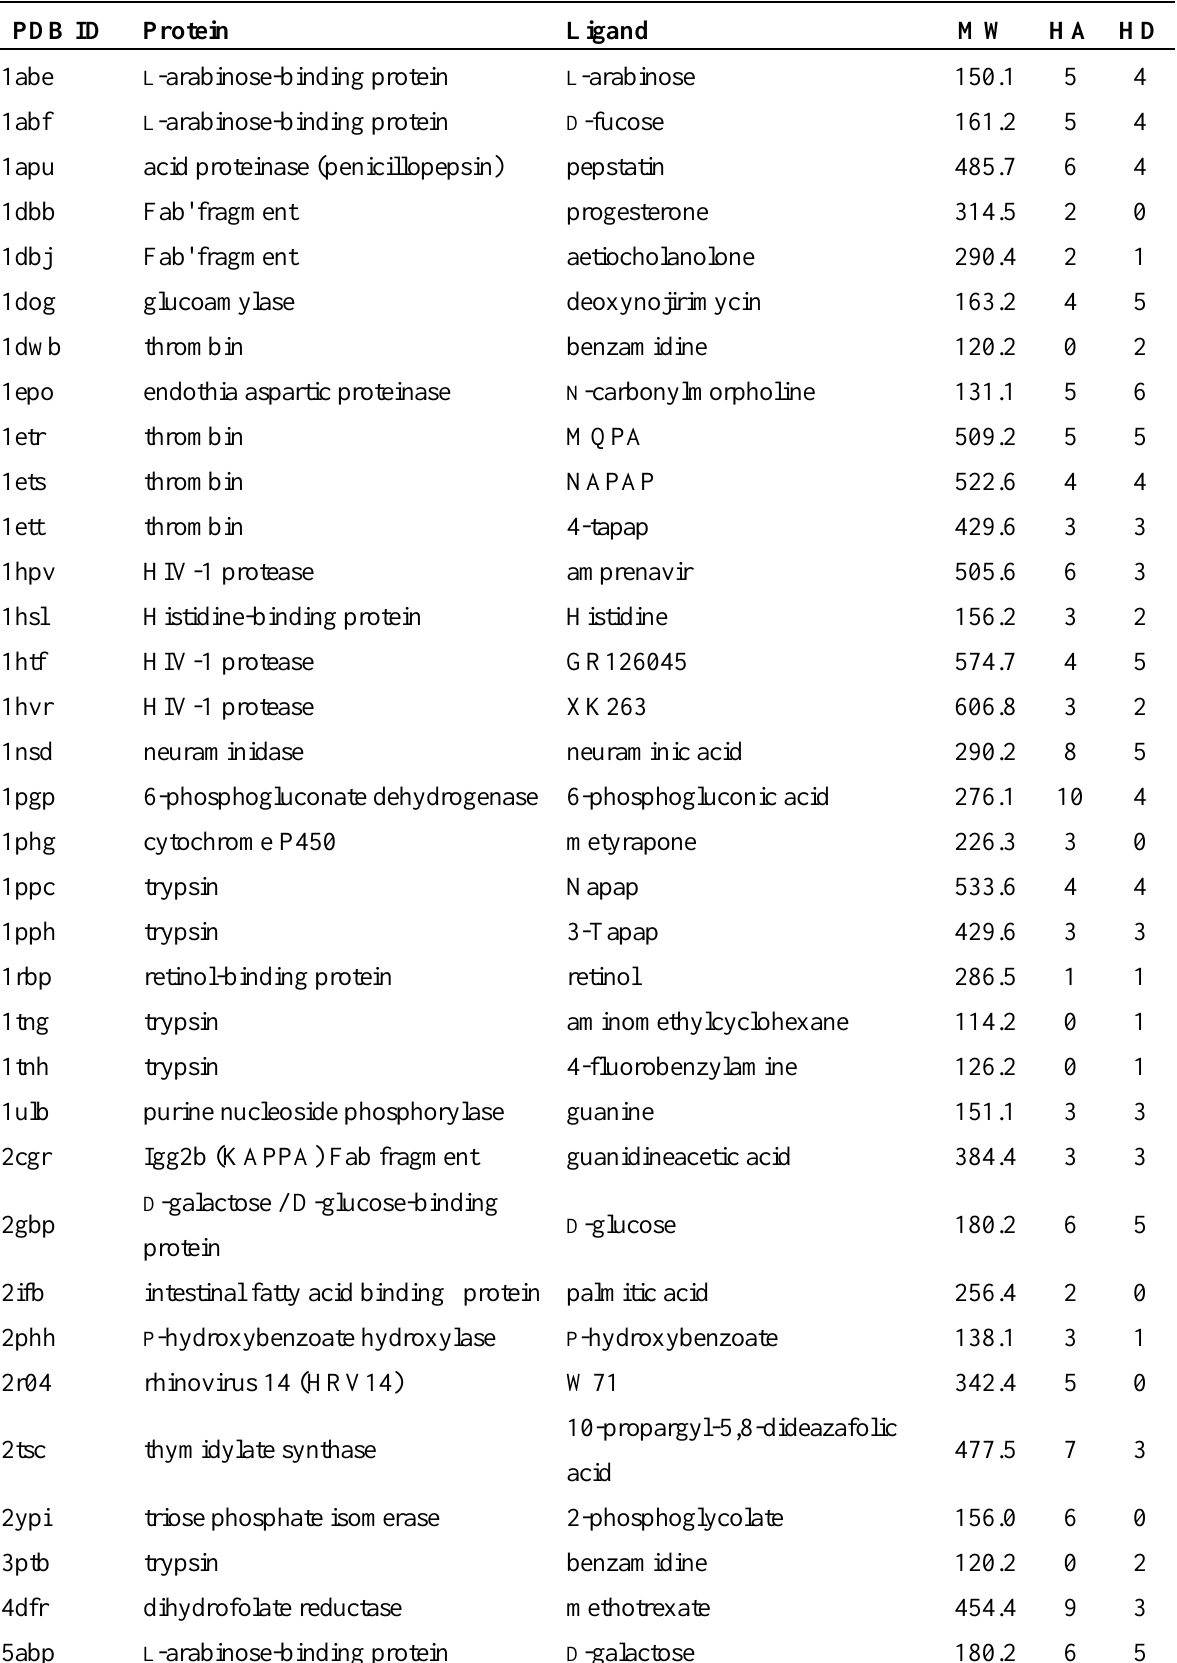
Table 5. List of the proteins and ligands